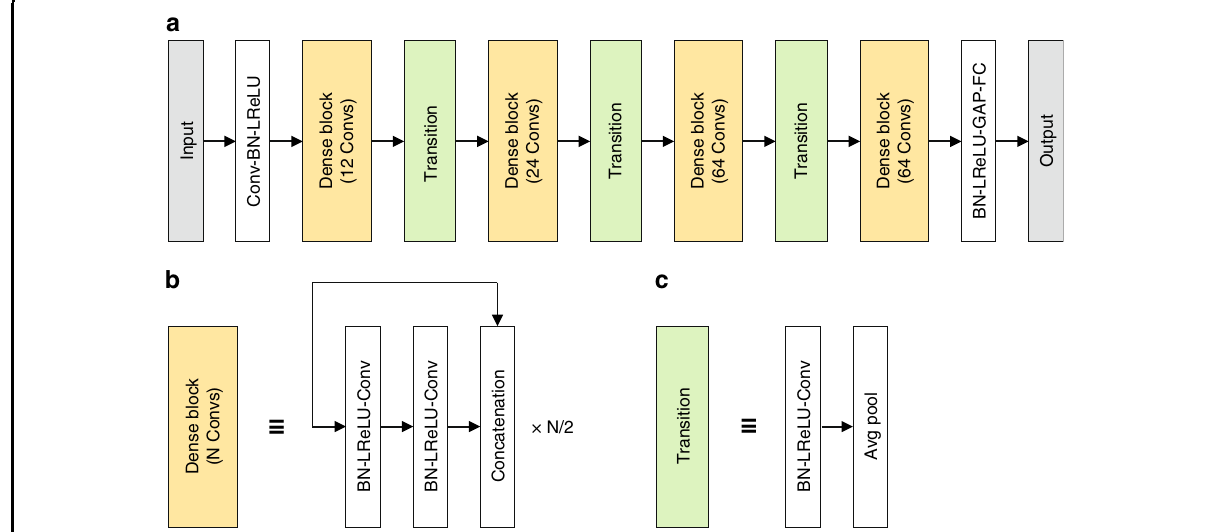
Fig. 2 The structure of the ANN utilized in our framework. a Four dense blocks and transition units between adjacent dense blocks represent the overall structure. Other elements include the initial 3D convolution operation (Conv) of 3 × 3 × 3 kernels and a stride of 2 × 2 × 2, batch normalization (BN), leaky recti fi ed linear units (LReLU), global average pooling (GAP), and fully connected operation (FC). b A dense block repeats a pair of Convs followed by a concatenation of the feature map. In each pair of Convs the fi rst one is of 1 × 1 × 1 kernels and the second one is of 3 × 3 × 3 kernels, while the stride is 1 × 1 × 1 for both. c The transition units shift the scale of the feature extracted by convolution. The Conv in each transition unit is of 1 × 1 × 1 kernels and a 1 × 1 × 1 stride